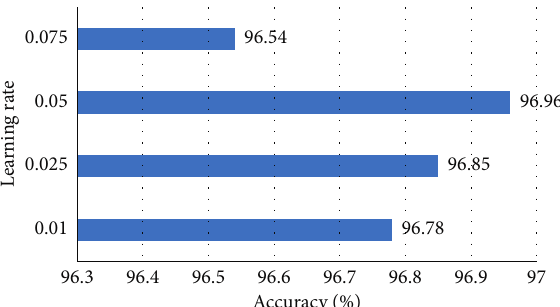
Figure 7: Classification accuracy of the MNIST dataset by the RReLU function N-D 2 NN model with different learning rates.